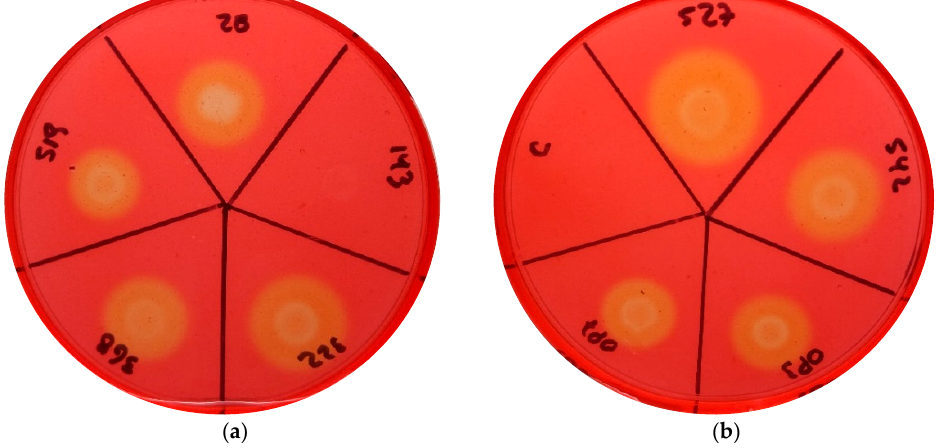
Figure 2. Results of virulence assay on tomato cv. San Pedro inoculated with nine Chilean C. michi- ganensis subsp. michiganensis strains. Data are expressed as mean ± standard deviation ( n = 15). Means with different letters indicate significant differences from each other ( p ≤ 0.05). Values ob- tained from the uninoculated control (zero) were excluded from the analyses of variance.